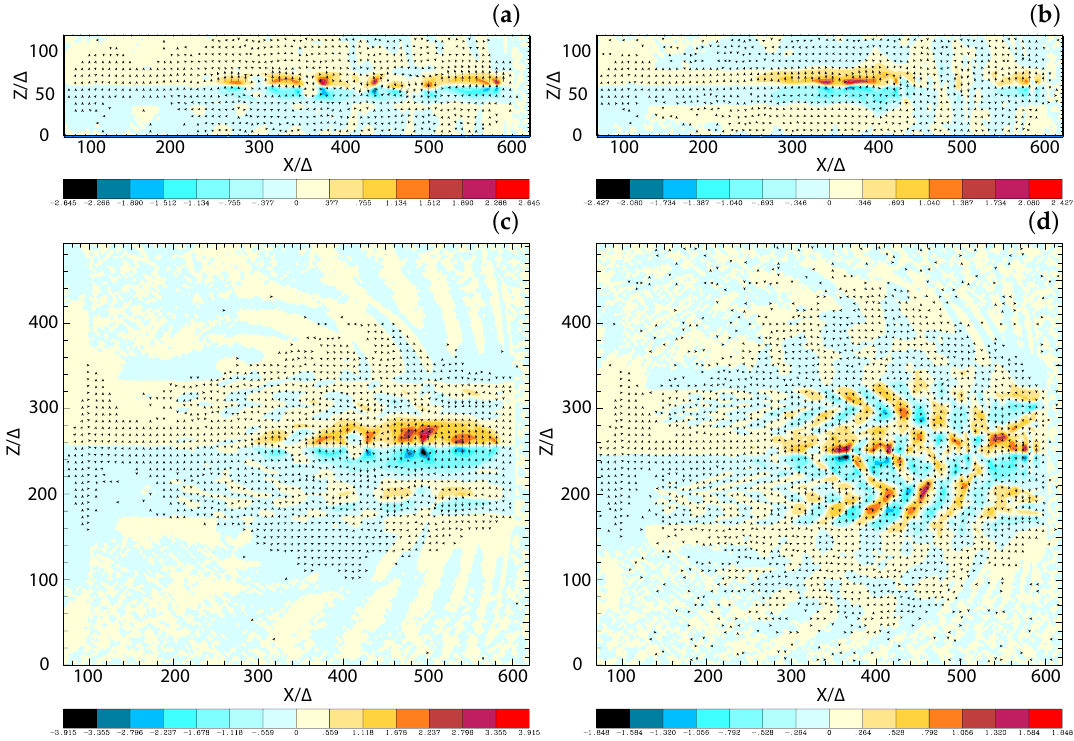
Figure 7. Isocontour plots of the azimuthal component of magnetic field B y intensity at the center of the jets for e − − p + ( a , c ) e ± ( b , d ) jets; with r jet = 20 ∆ ( a , b ) r jet = 80 ∆ ( c , d ) at time t = 500 ω − 1 pe . The disruption of helical magnetic fields are caused by instabilities and/or reconnection. The max/min numbers of panels are ( a ) ± 2.645, ( b ) ± 2.427, ( c ) ± 3.915, ( d ) ± 1.848. Adapted from Figure 1 in Nishikawa et al.